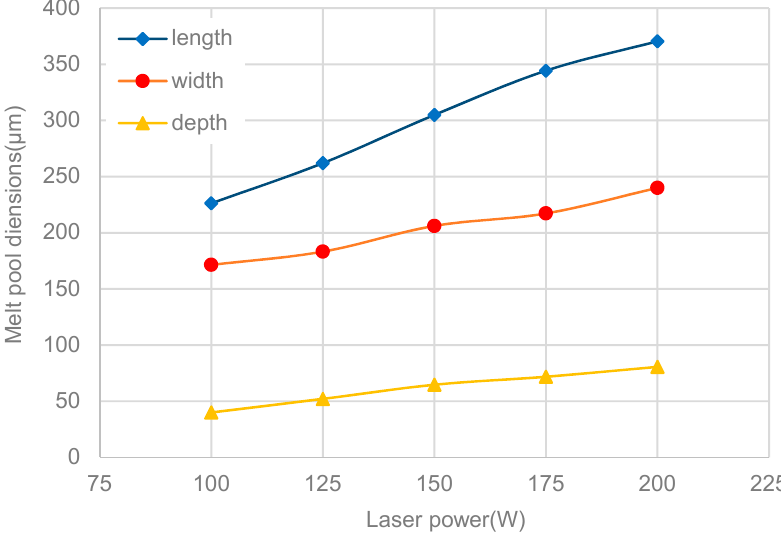
Figure 12. Melt-pool dimensions at different laser power levels.